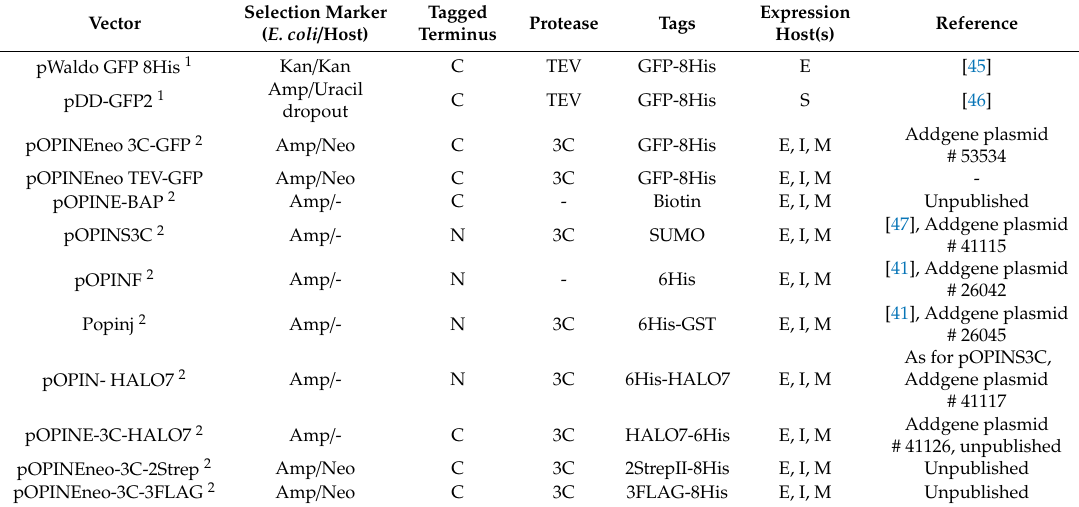
Table 2. Expression vectors commonly used at MPL. Expression hosts abbreviated as follows: E. coli (E), S. cerevisiae (S), insect (I), mammalian (M). Many vectors contain a green fluorescent protein (GFP) tag that is used to assess protein expression, localisation and monodispersity before large-scale